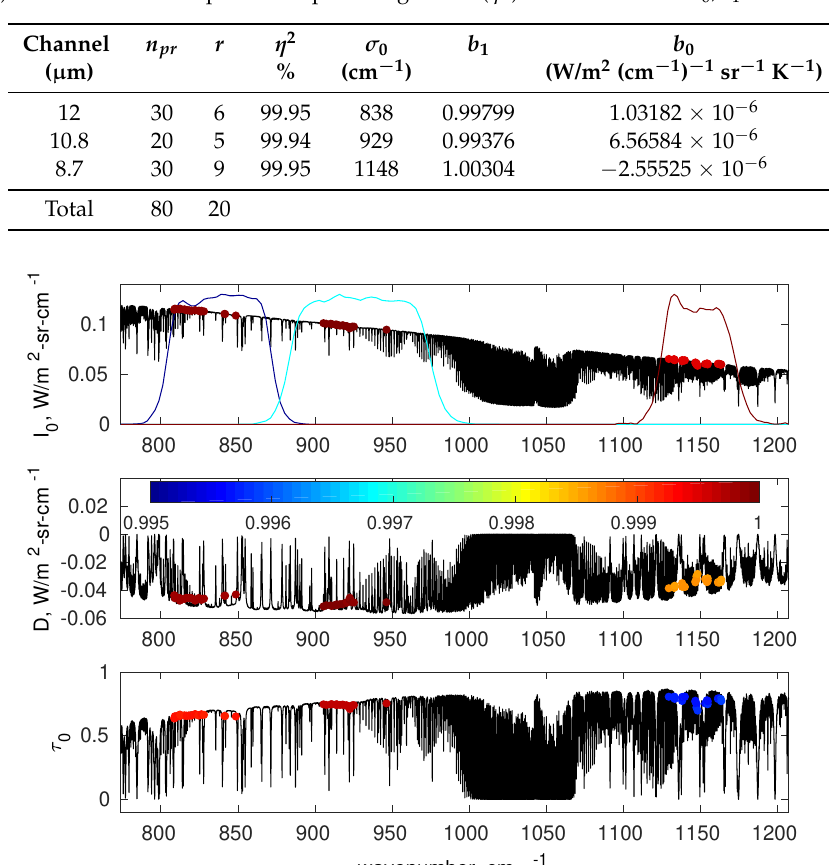
Figure 1. Example for the selection of monochromatic predictors I 0 ( top panel), D ( middle panel) and τ 0 ( bottom panel). The shown monochromatic predictors exemplify a tropical sate vectors over the spectral range 750 to 1200 cm − 1 . The position of the n pr predictors are indicated with coloured circles; the colour scale shows the linear correlation coefficient between SEVIRI channel quantities ( (cid:104) I 0 (cid:105) , (cid:104) D (cid:105) and (cid:104) τ 0 (cid:105) ) and the single monochromatic predictor. In the top panel coloured lines indicate to the ISRF of the three SEVIRI channels used in this